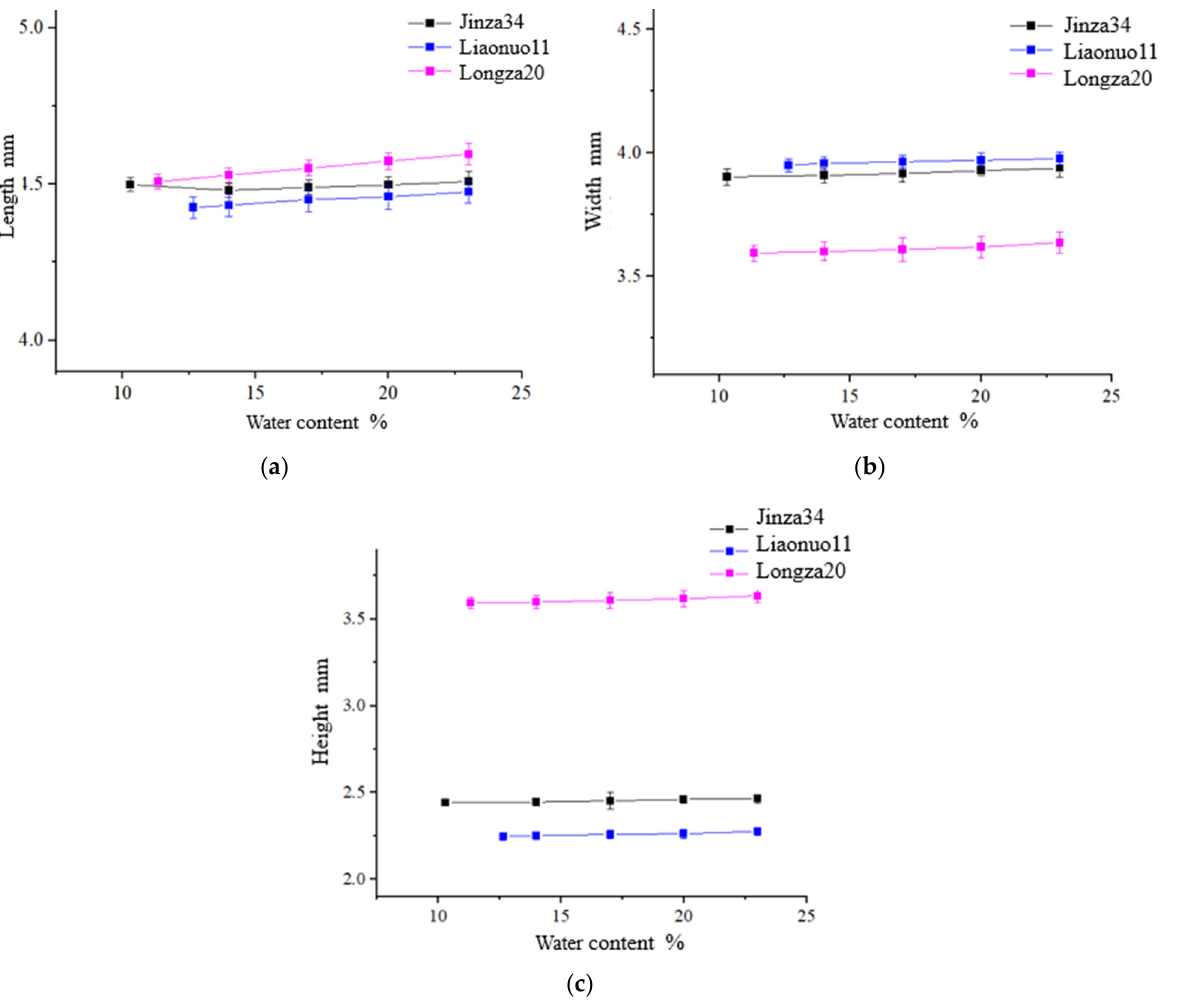
Figure 6. Comparison of the triaxial size of sorghum seeds of different varieties. ( a ) Length. ( b ) Width. ( c ) height.